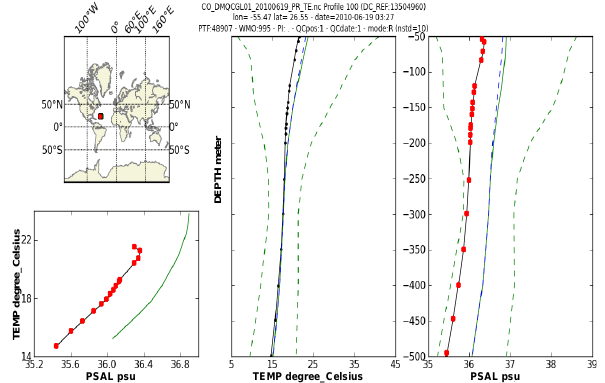
Fig. 5. Example of a profile that fails the offset test for salinity ob- servations. The in-situ profile is shown in black, the climatology and its 10 σ envelope in green. Red dots indicate observations extracted by the test.